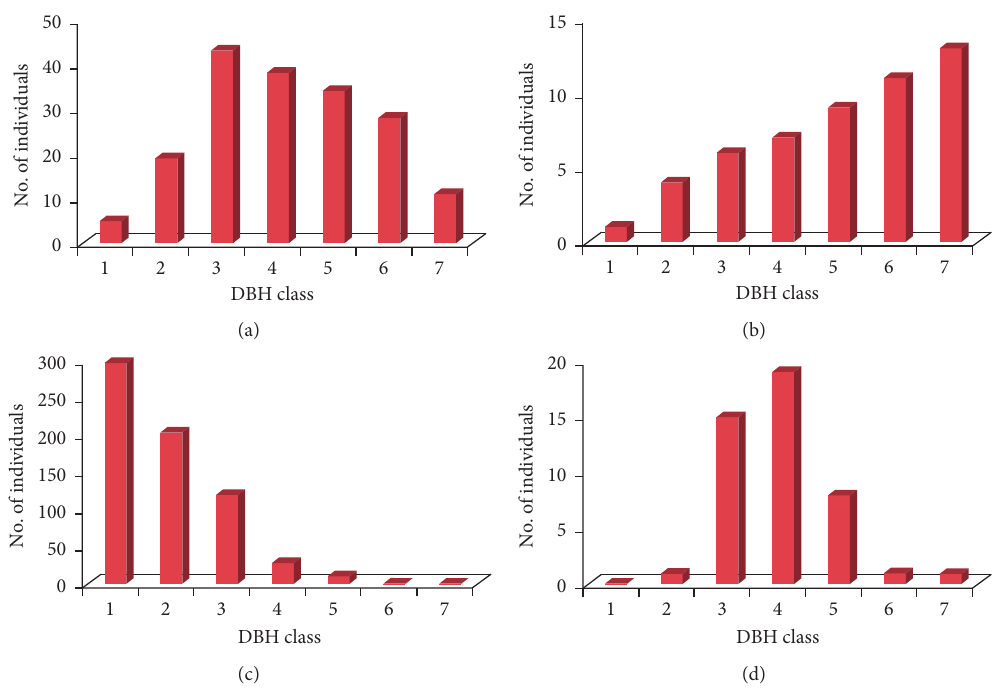
Figure 2: (a–d) Pattern of frequency distribution of selected tree species over DBH classes (DBH classes: 1 � 2.5–10cm; 2 � 10.01–20cm; 3 � 20.01–50 cm; 4 � 50.01–80cm; 5 � 80.01–110cm; 6 � 110.01–140cm; 7 ≥ 140cm). (a) Olea welwitschii . (b) Schefflera abyssinica . (c) Elaeodendron Buchananii . (d) Sapium ellipticum